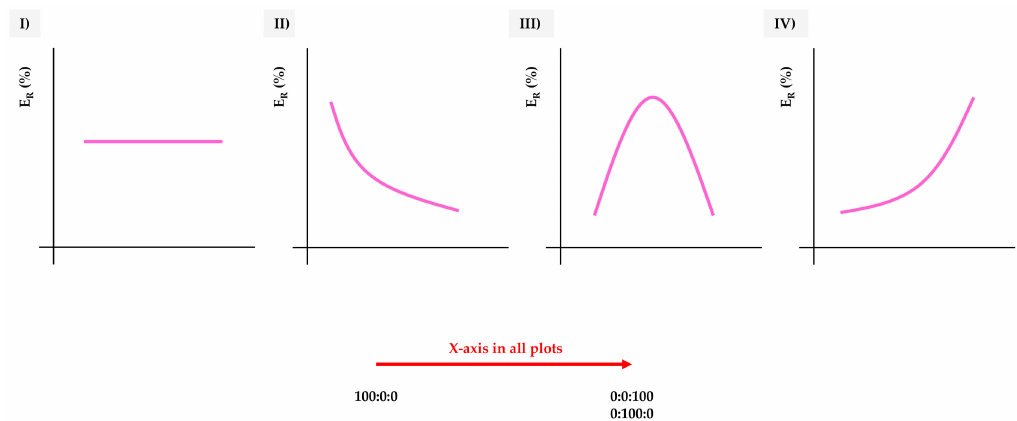
Figure 3. Types of general trends observed when extracting the target analytes by dispersive miniaturized solid-phase extraction (D- µ SPE)-high-performance liquid chromatography